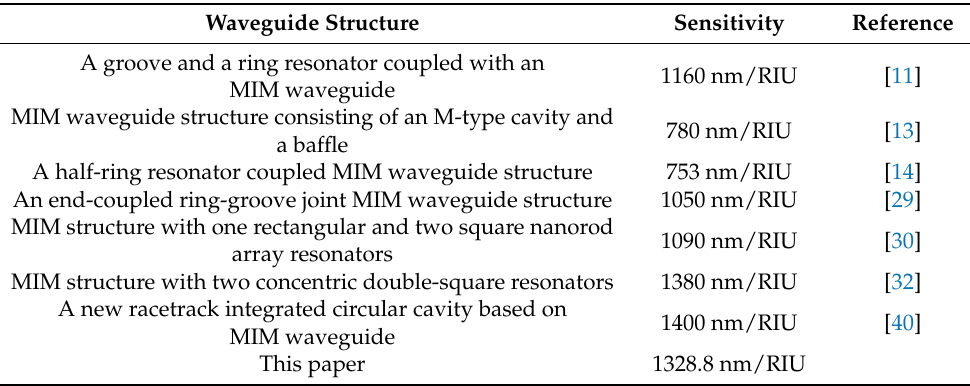
Table 2. Comparison of the sensitivity with other